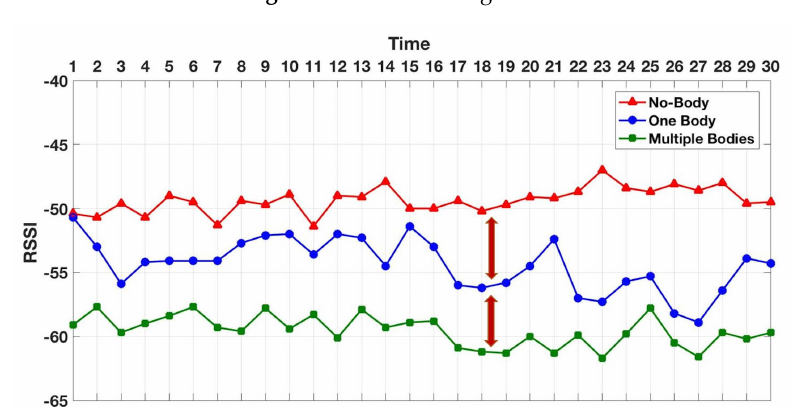
Figure 18. Indoor average RSSI.